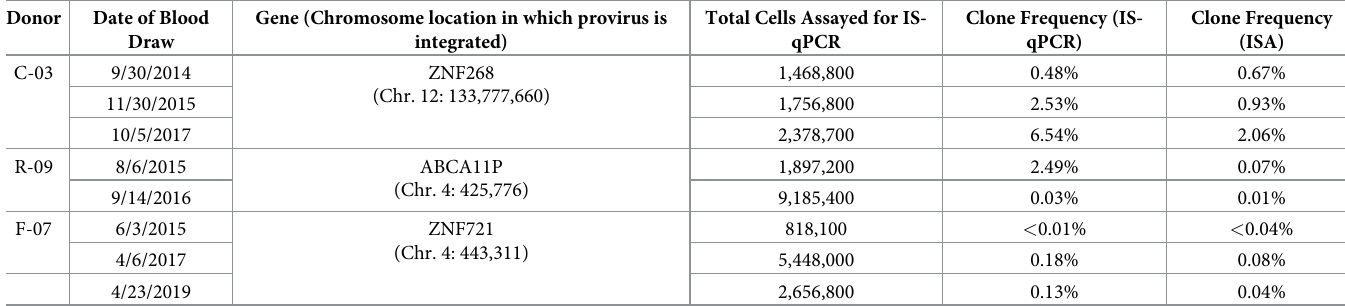
Table 4. Stability of Clones that Carry Intact Infectious